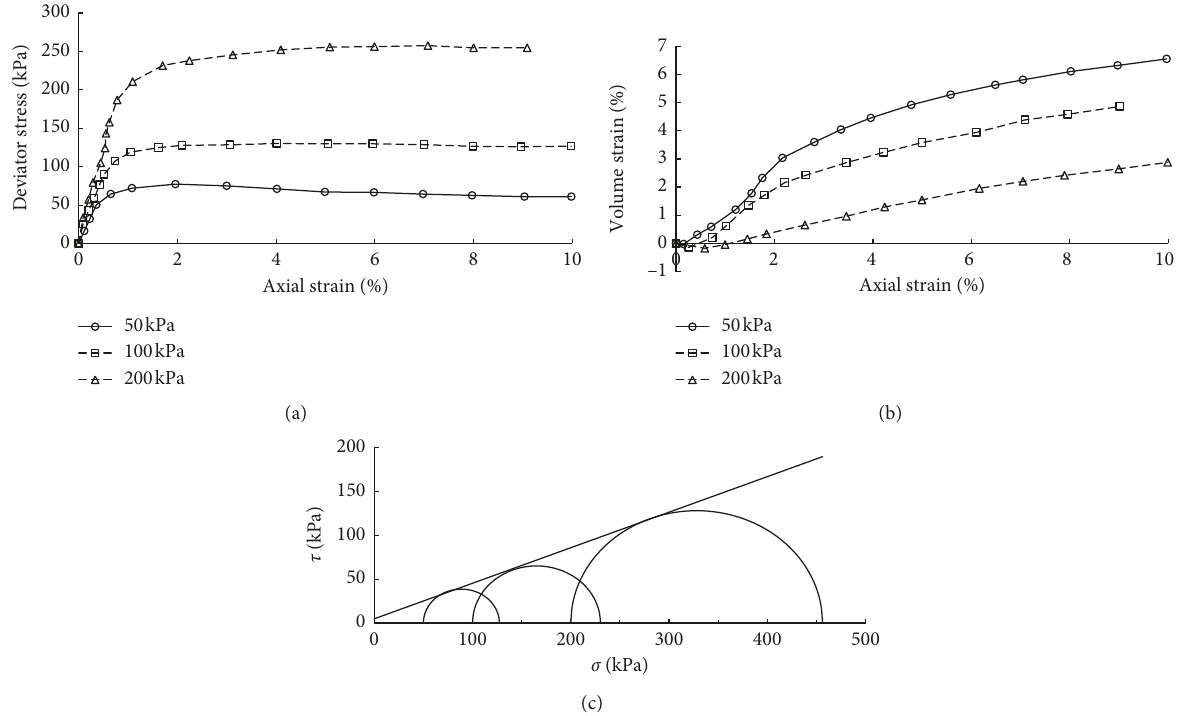
Figure 12: Results of the consolidation-drained triaxial shear test; (a) stress-strain curves; (b) variation in volume strain with shearing strain; (c) Mohr